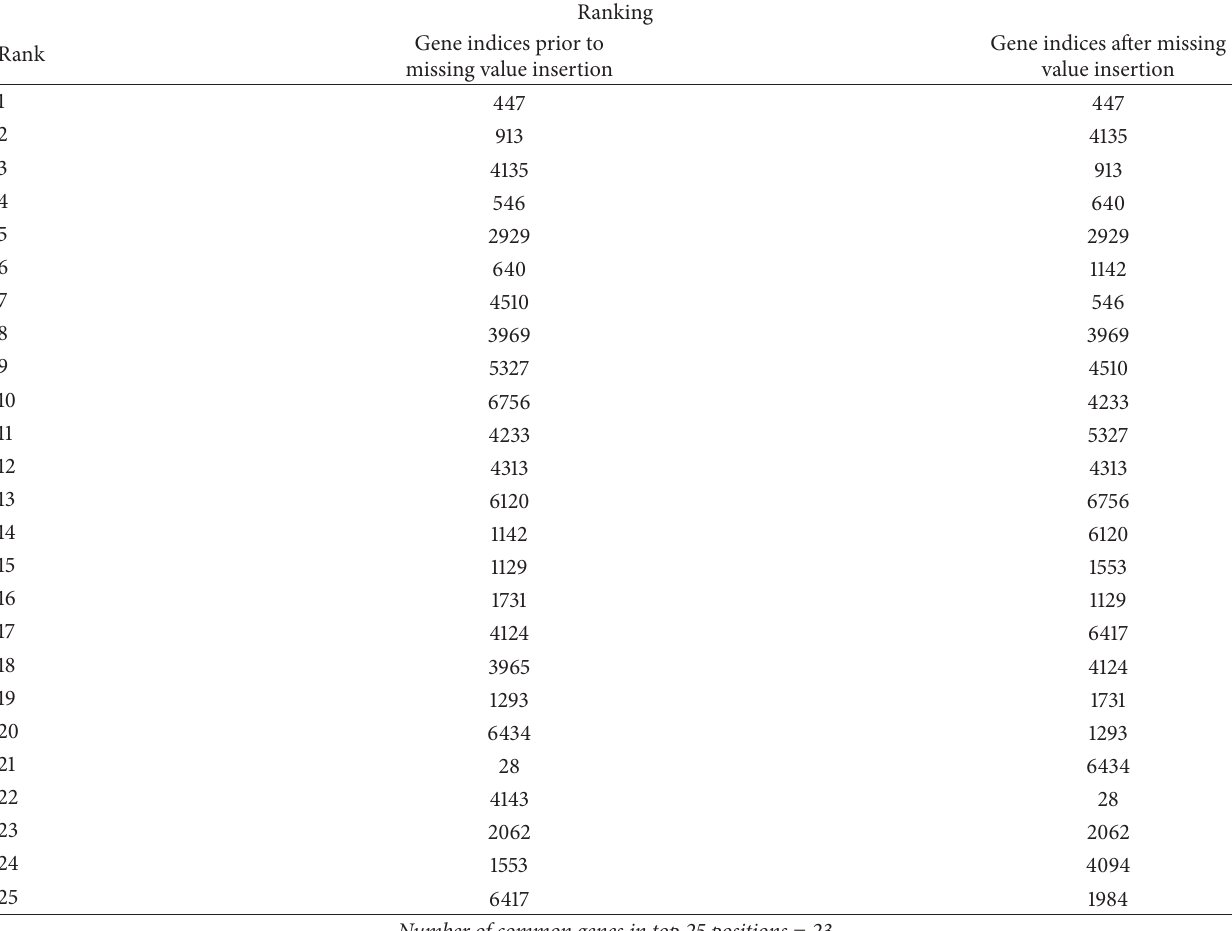
Table 14: Top 25 gene indices before and after estimation for DLBCL-FL.